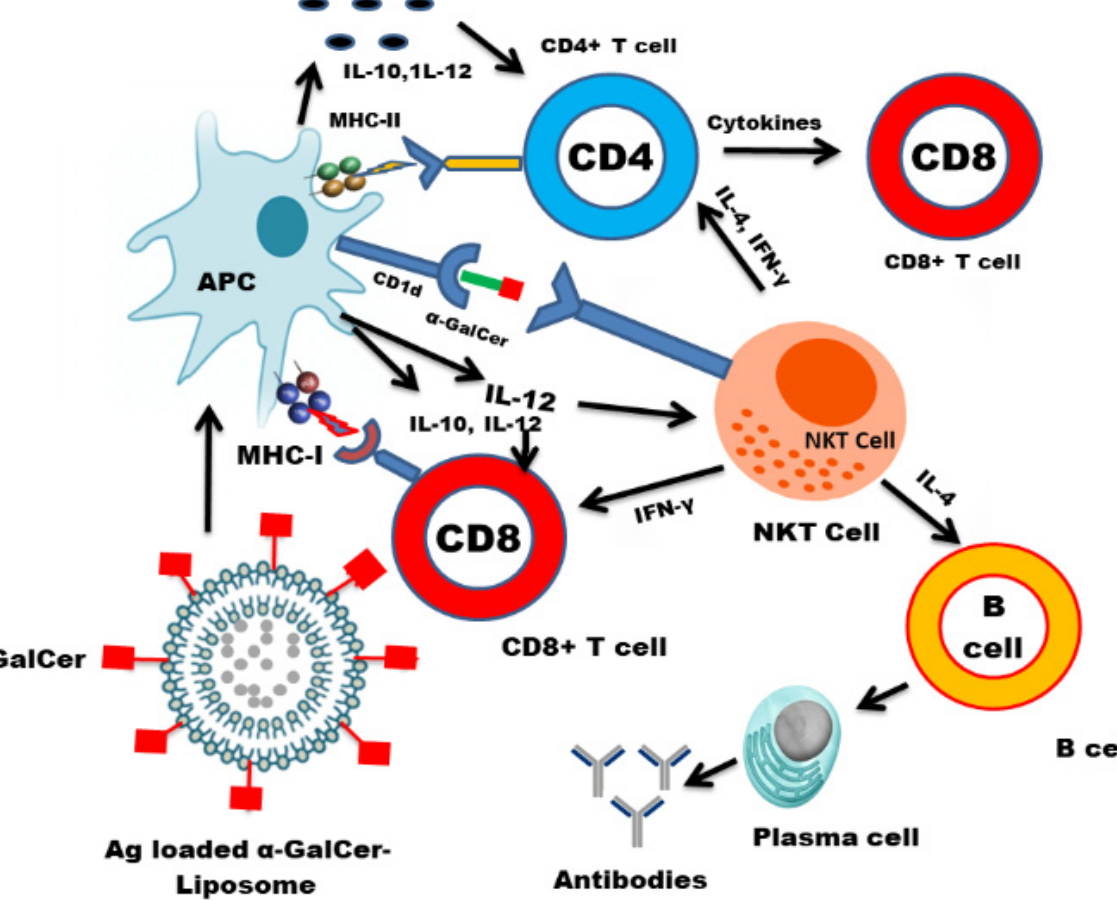
Figure 4. Liposome-incorporated α -GalCer and antigens are preferentially taken up and presented by dendritic cells. Liposomes deliver the encapsulated molecules to the cytoplasm and intracellular compartments of the APC for the processing of antigens. It results in the activation of CD8 + T cells, CD4 + T cells and NKT cells. NKT cells secrete both Th1 and Th2 cytokines that induce the proliferation of the cell-mediated and humoral immune responses. The NKT cells show immune-stimulating activity through the maturation of the den- dritic cells and boosting of antibody production [98,99]. Since they induce a rapid matu- ration of the dendritic cells (DCs) and B cells, their activation may elicit a strong antigen-